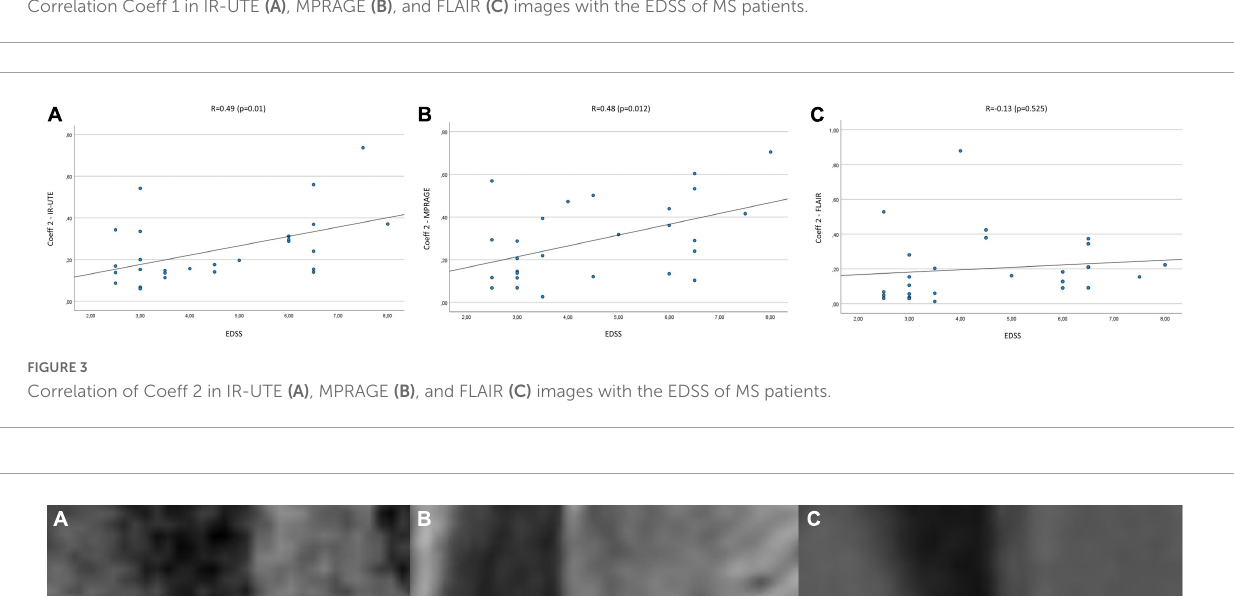
FIGURE2 Correlation Coeff 1 in IR-UTE (A) , MPRAGE (B) , and FLAIR (C) images with the EDSS of MS patients.